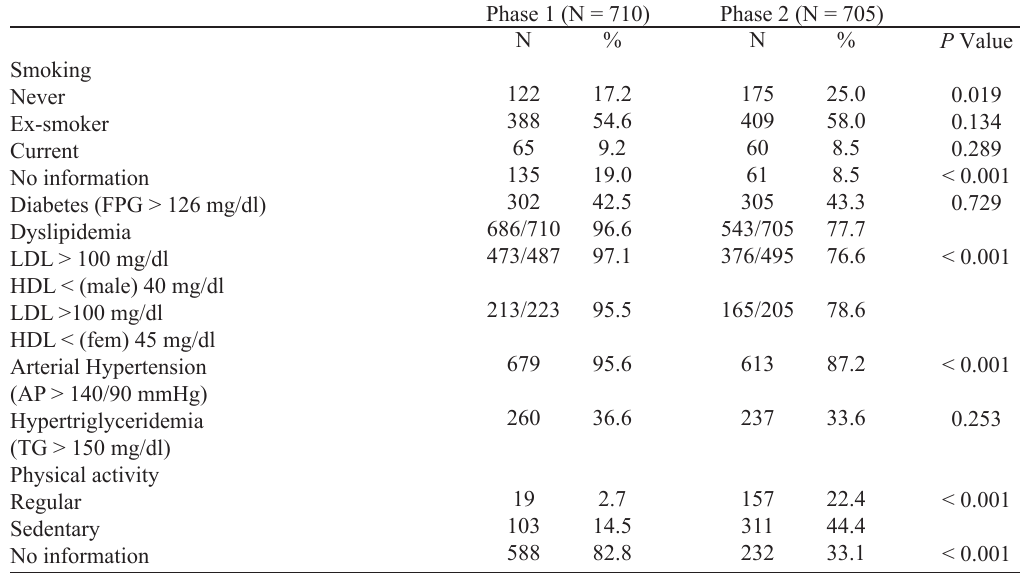
Table 2. Associated risk factors.